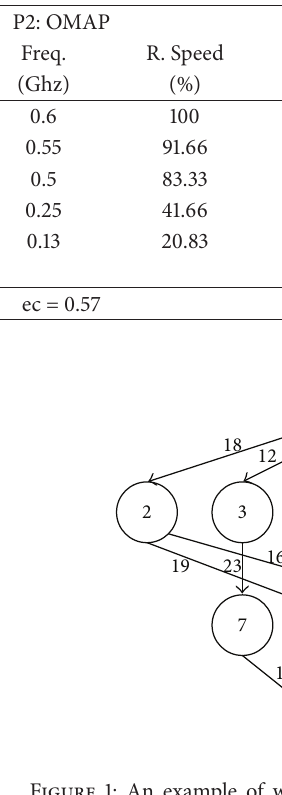
Table 1: Voltage Scaling Levels and relative speeds of processors.